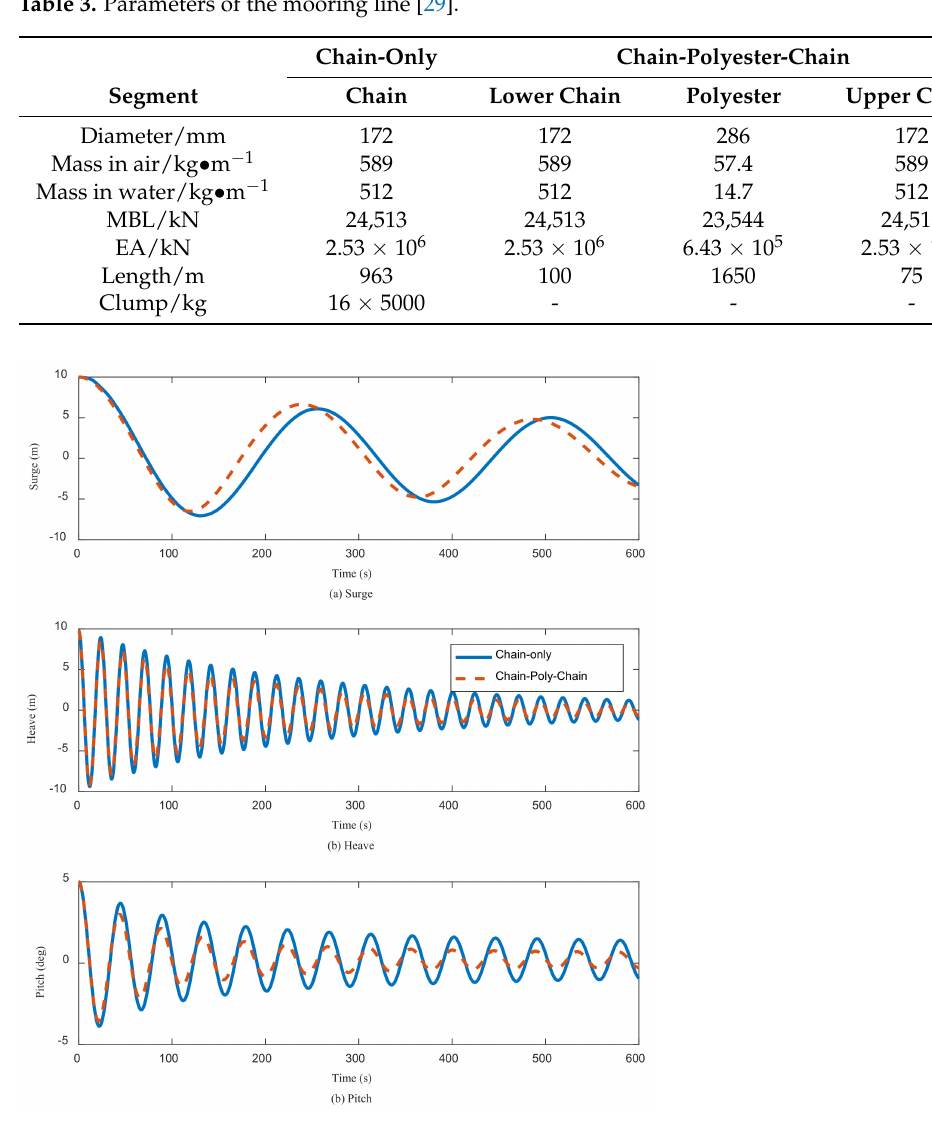
Figure 10. Time histories of the free-decay simulations. Table 4. Natural frequencies based on the free-decay simulations